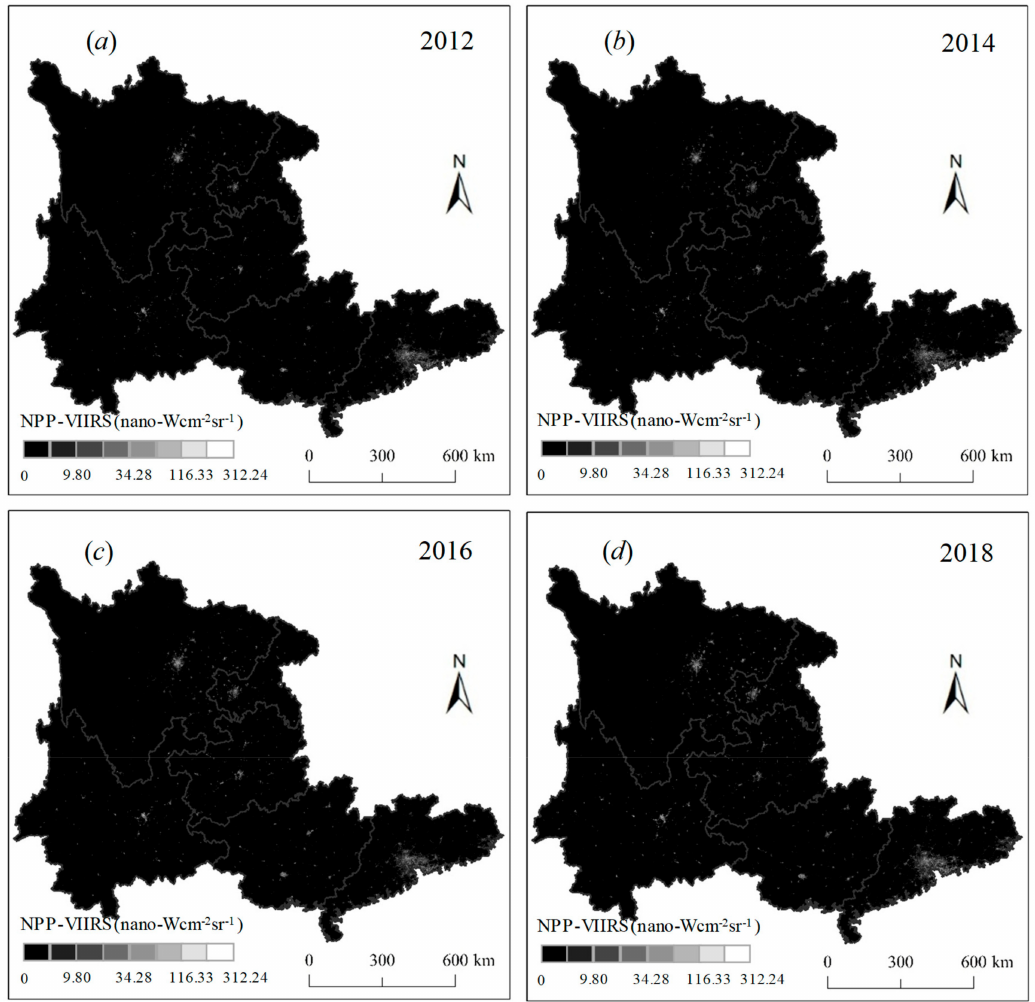
Figure 2. The corrected annually average National Polar-orbiting Partnership (NPP) Visible Infrared Imaging Radiometer Suite (VIIRS) data from 2012 to 2018—( a ) 2012; ( b ) 2014; ( c ) 2016; ( d )